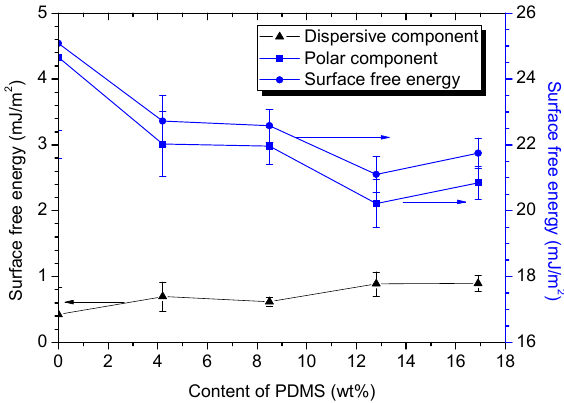
Figure 7. Water contact angle (WCA) and diiodomethane contact angle (DCA) measured results of the PU-Sis samples.